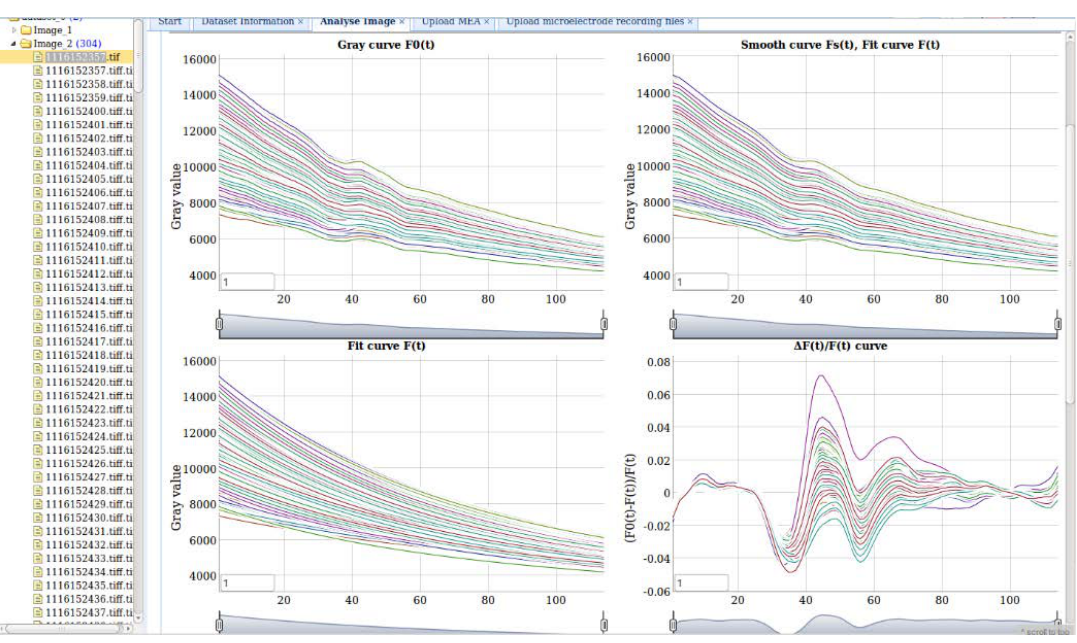
Figure 8. Web-based plant electrical signals extraction from fluorescence images.